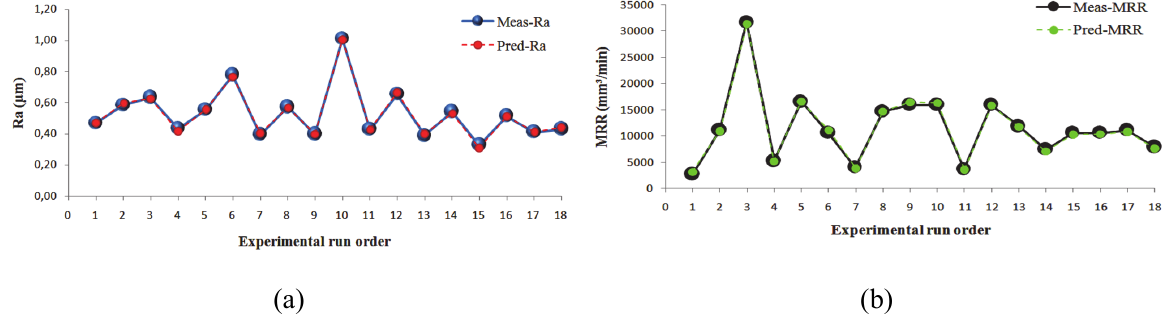
Fig. 10. Measured vs. predicted values of performance characteristics: (a) surface roughness, (b) material removal